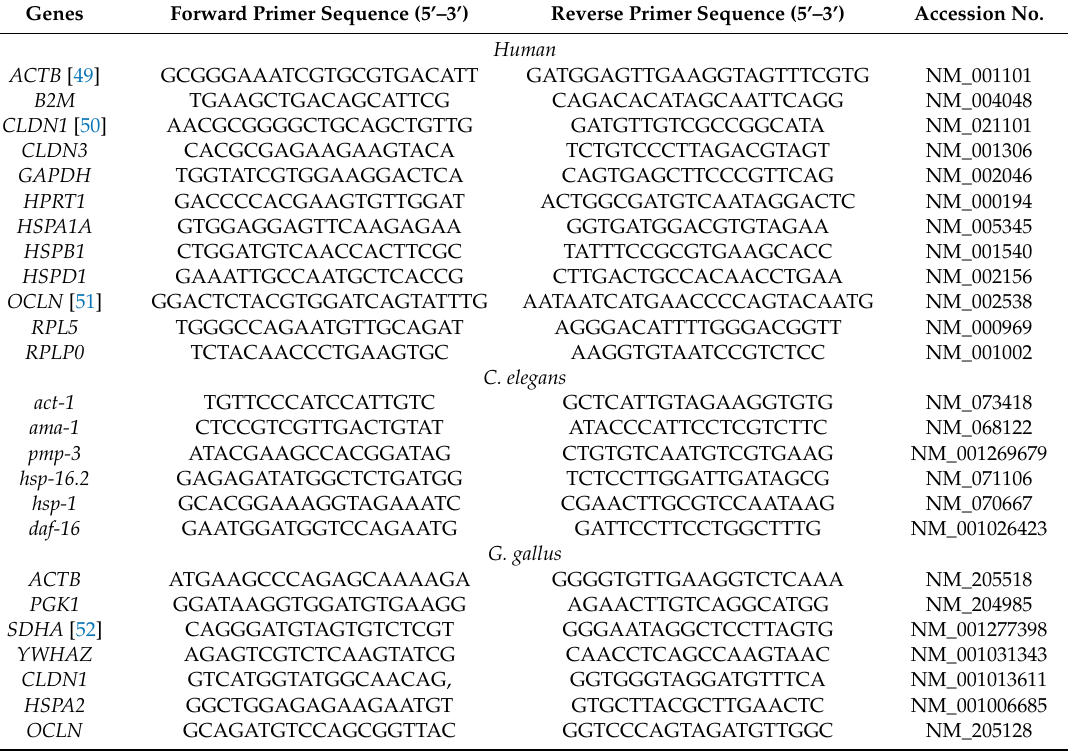
Table 3. Analysed genes in qPCR experiments with Caco-2 cells (human), C. elegans and broilers ( Gallus gallus ) and the oligonucleotide sequences of primers